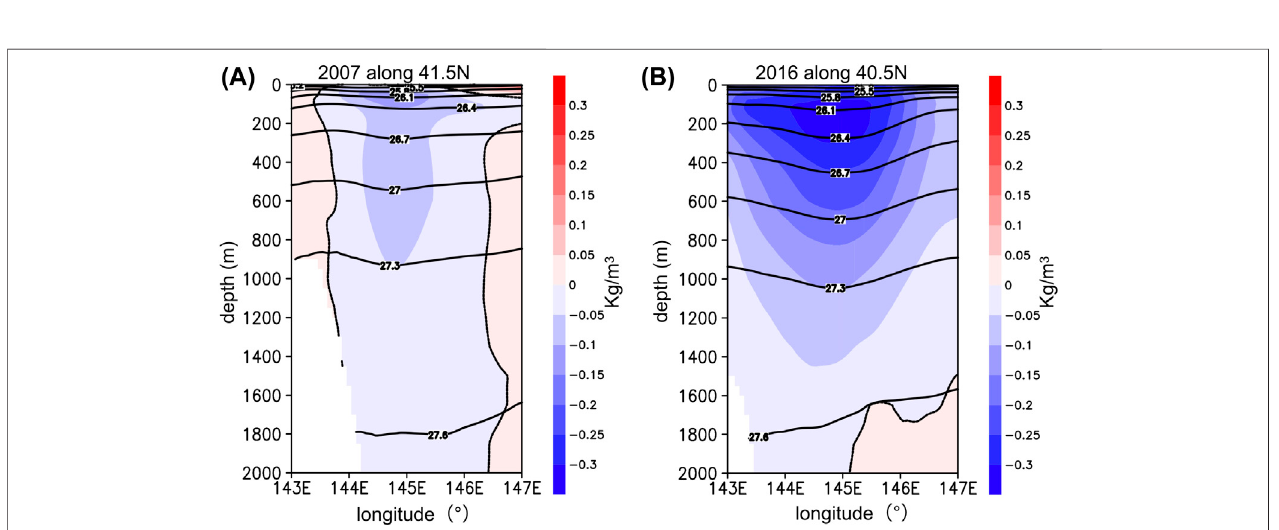
FIGURE4|(A) Longitude-depthdiagramoftheyearlyaveraged σ θ (contour)and σ θ anomaly(shadedcolor)fortheyear2007,alongthe41.5 ° N-horizontallinefrom 143 ° Eto147 ° Ewhichisindicatedbytheblacklinein Figure3A .Theunitiskg/m 3 . (B) Sameas (A) butfortheyear2016along40.5 ° N-horizontallinefrom143 ° Eto147 ° E which is indicated by the black line in Figure 3B